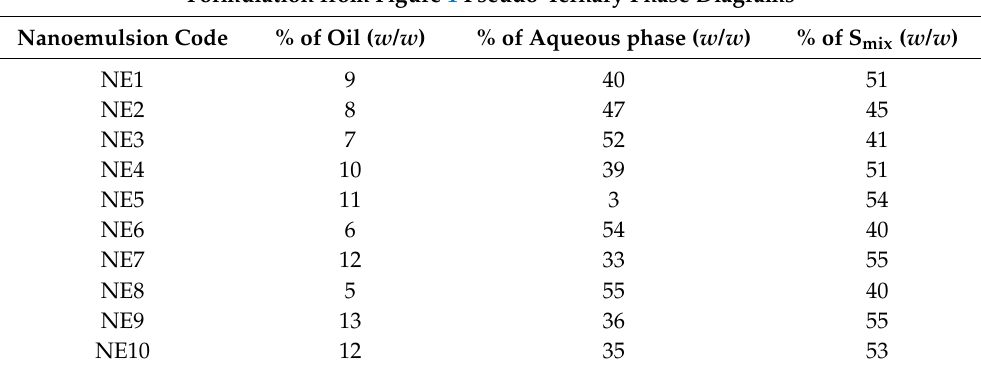
Table 1. Composition of selected nanoemulsions at the S mix ratio of 3:1. Formulation from Figure 1 Pseudo-Ternary Phase